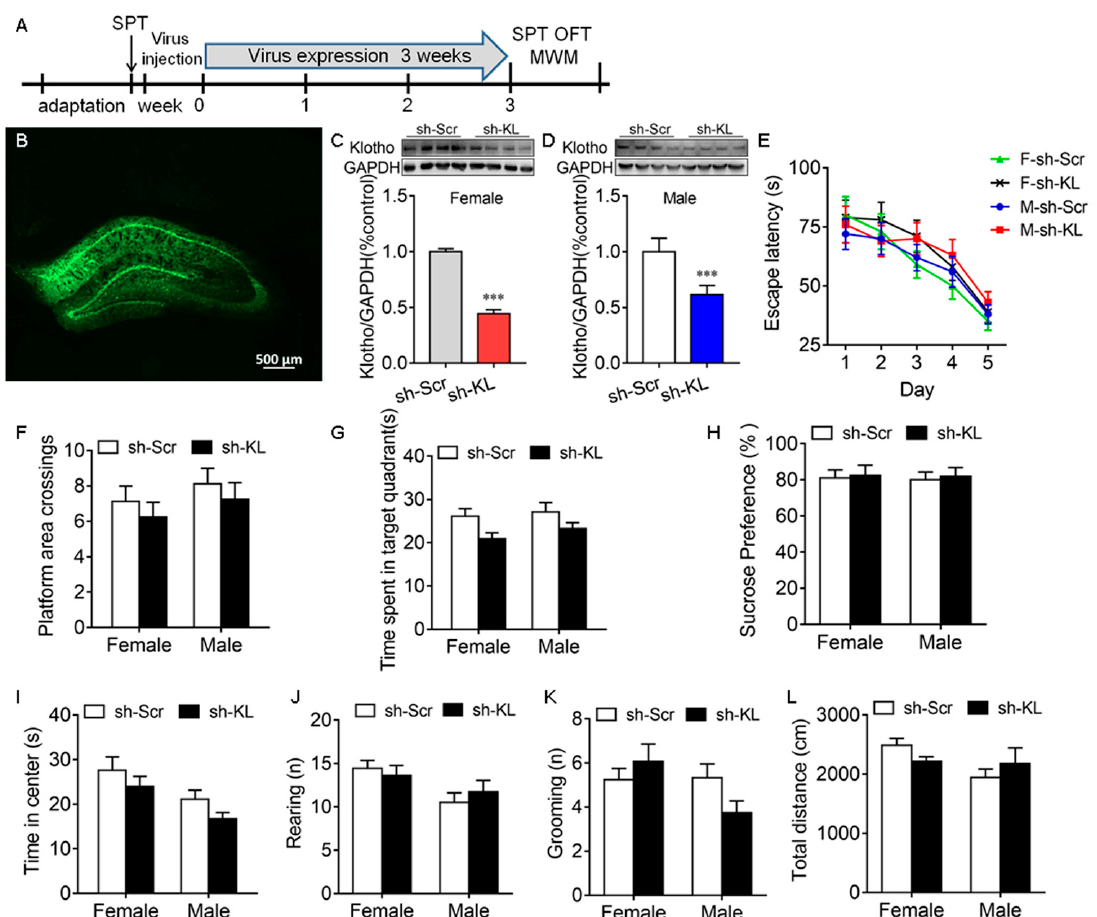
Figure 4. AAV-mediated decrease in the expression of hippocampal klotho (KL) protein did not impair spatial learning and memory in the Morris water maze test and induce anhedonic-like behaviors. Experimental design. Sucrose preference test (SPT), open-field test (OFT), and Morris water maze (MWM) test ( A ). Representative image of AAV-KLshRNA-GFP expression ( B ). Western blot analysis showed a decrease in the levels of hippocampal KL protein (130 kDa) due to Klotho shRNA (sh-KL) compared to scrambled shRNA (sh-Scr) in female ( C ) and male ( D ) rats. In the MWM test, the decreased expression of KL did not alter the latency to the platform on days 1–5 during training in the MWM ( E ), the number of platform area crossings ( F ), and the time spent in the target quadrant on day 6 ( G ) during the probe trial in male and female rats. No significant difference between the sh-KL and sh-Scr groups in sucrose consumption was found in the SPT ( H ). Time spent in the center of the open field ( I ), the number of rearing times ( J ), the number of grooming times ( K ), and the total distance traveled ( L ) in the OFT. ( C , D ) t -test; ( E ) two-way repeated-measures ANOVA; ( F – L ) two-way ANOVA followed by Tukey’s test. Data are shown as the mean ± SEM. *** p < 0.001, n =